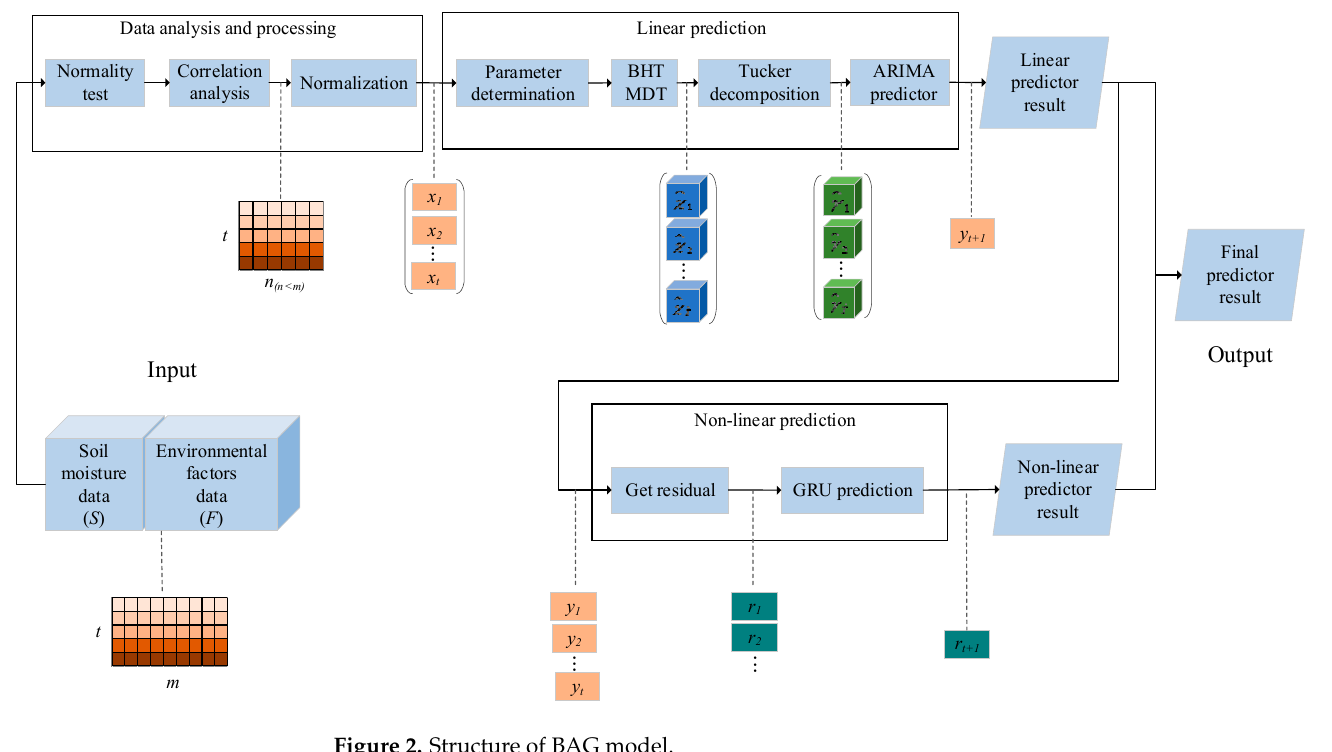
Figure 2. Structure of BAG model.